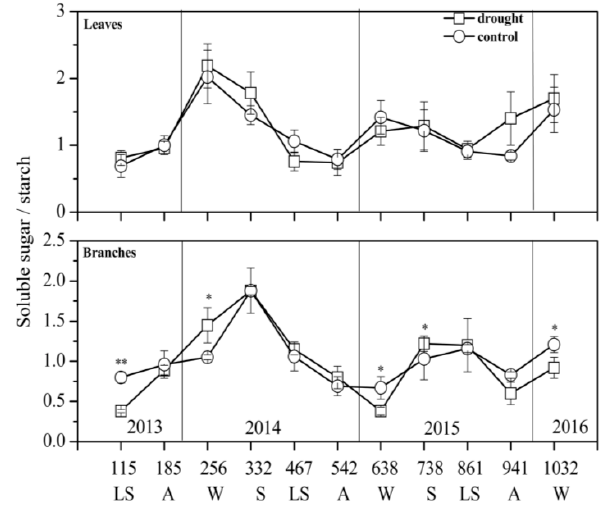
Figure 7. The ratio of soluble sugar to starch in leaves and branches of Pinus massoniana under control and drought treatments (mean ± SD). Samples were collected in late summer (LS), autumn (A), winter (W), and late spring (S) from 2013 to 2016. Variables marked with asterisks indicate a significant difference between the control and drought groups (** p < 0.01, * p < 0.05).